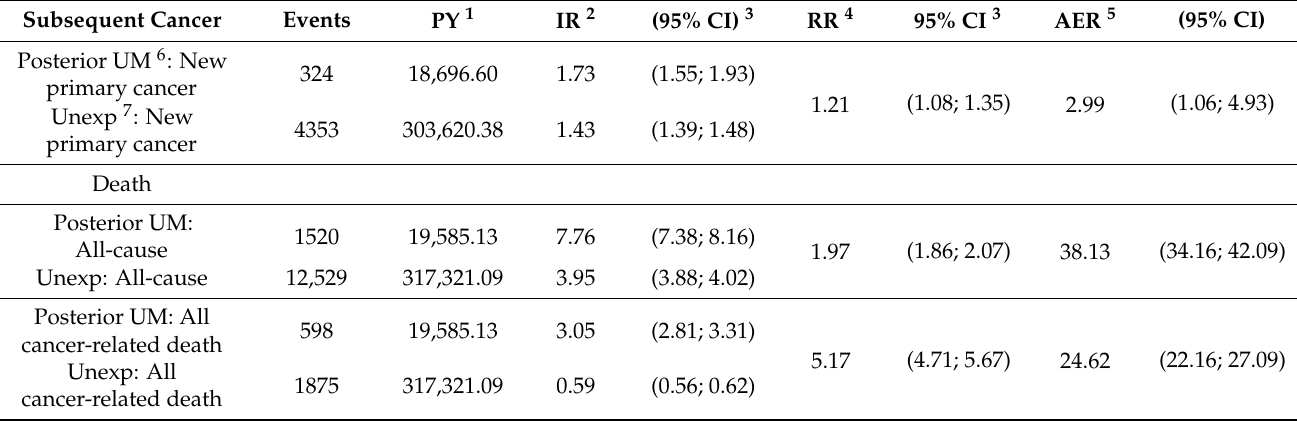
Table 2. Crude rates of new primary cancer (all cancer types except posterior uveal melanoma and non-melanoma skin